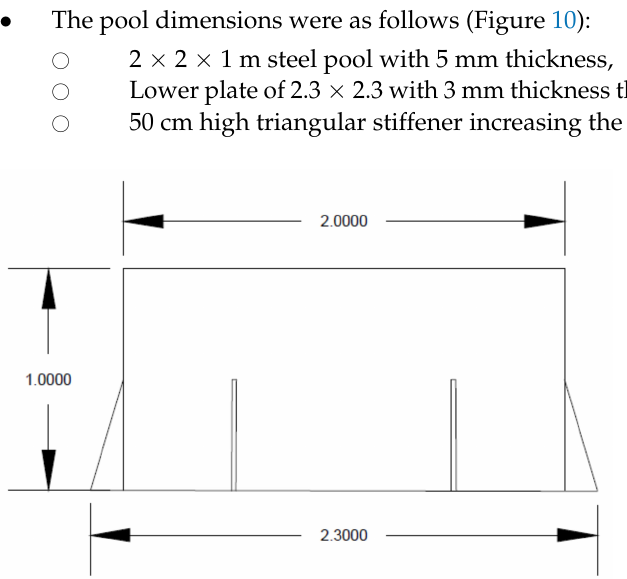
Figure 10. Outline of the pool in